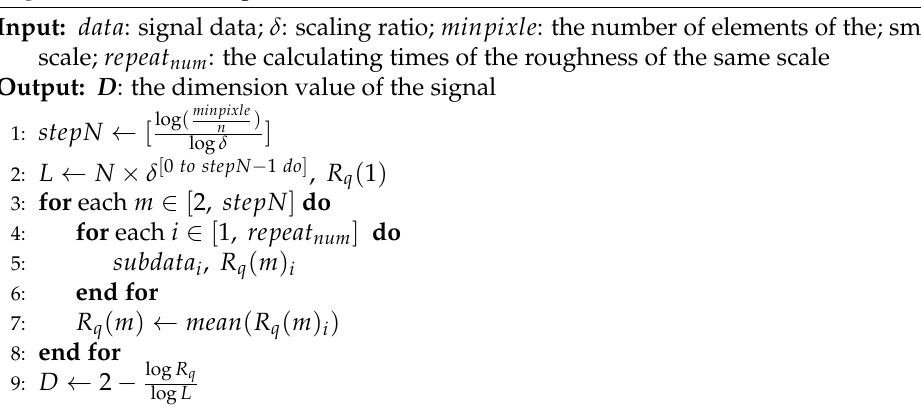
Algorithm 1 RSE-f0